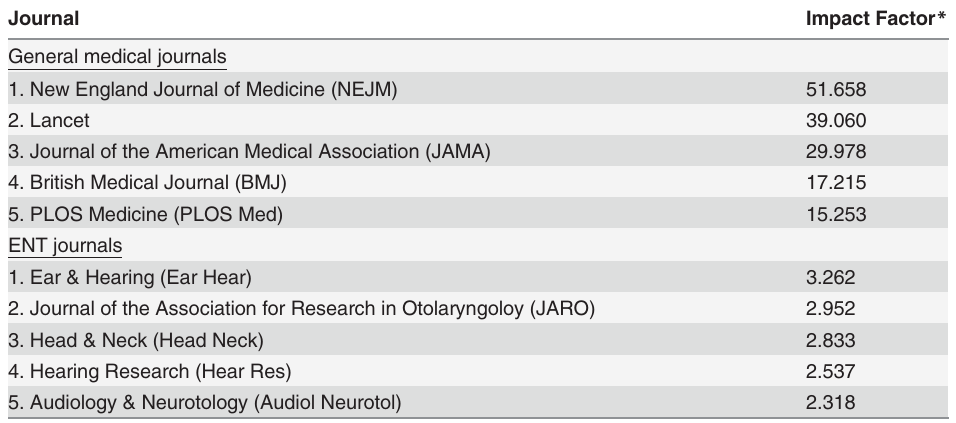
Table 1. Impact Factors 2012 Top 5 general medical and ENT